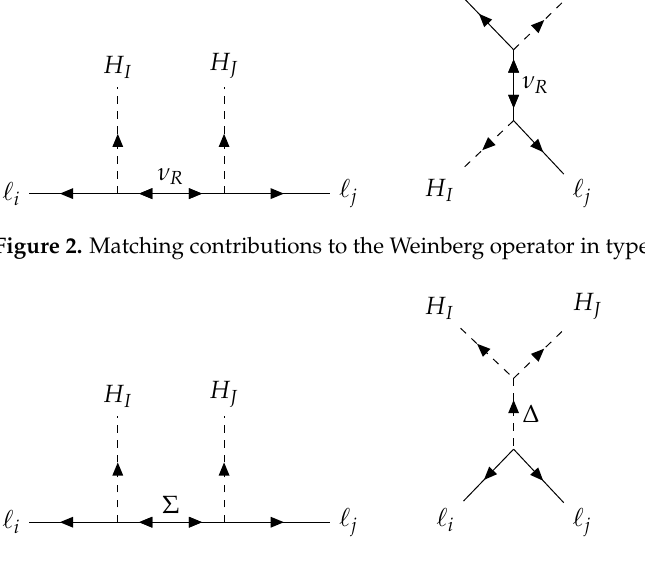
Figure 3. Seesaw Majorana neutrino masses generated by integrating out a heavy scalar triplet ∆ (type II) or a heavy fermion triplet Σ (type